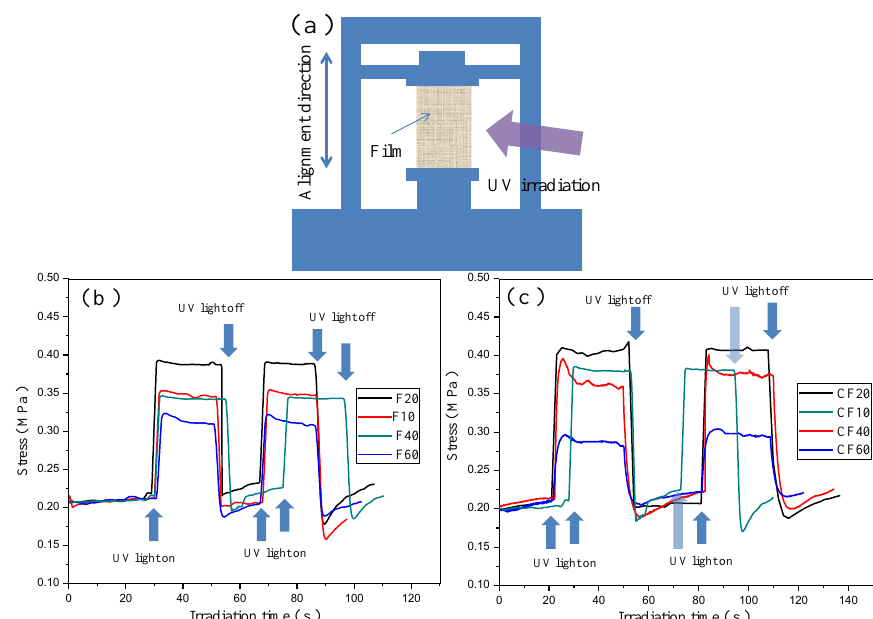
Figure 5. ( a ) Schematic illustration of the experimental setup for measuring the photoinduced stresses of AZO-CLCP films and AZO-CLCP/CNT nanocomposite films under irradiation of UV light. Size of the films: 12 mm × 6 mm × 20 μ m. The wavelength and intensity of the used UV light was 366 nm and 1.5 mW/cm 2 respective. The room lamplight kept turning on state constantly; ( b ) Photoinduced stresses of the AZO-CLCP films; ( c ) Photoinduced stresses of the AZO-CLCP/CNT nanocomposite films. The AZO-CLCP films and AZO-CLCP/CNT nanocomposite films showed anisotropic mechanical properties due to the anisotropic network structure of AZO-CLCP matrices. The tensile strengths were measured both parallel and perpendicular to the alignment direction by using the universal material mechanical analyzer (Figure S3), and the results are summarized in Table 1. The stress-strain curves of some AZO-CLCP films and AZO-CLCP/CNT nanocomposite films are in the Supporting Information (Figure S4). The films demonstrated better mechanical properties in the parallel direction than in the perpendicular direction. On the other hand, the tensile strengths of the AZO-CLCP/CNT nanocomposite films were obviously higher than those of the AZO-CLCP films, this should be attributed to the reinforcement effect of the CNT sheet. Table 1. Mechanical properties of the AZO-CLCP films and AZO-CLCP/CNT nanocomposite films measured parallel ( ‖ ) and perpendicular ( ┴ ) to the alignment direction. The superior photo actuation performances, well mechanical properties and robustness feature demonstrated by the AZO-CLCP/CNT nanocomposite films, are promising for application in light- driven smart actuators. Considering the optimum photo actuation performance of CF20, we demonstrated it as a light-controlled microvalve membrane actuator for a conceptual device of microfluidic system, the experimental setup is shown in Figure 6a. Inside the polymethyl